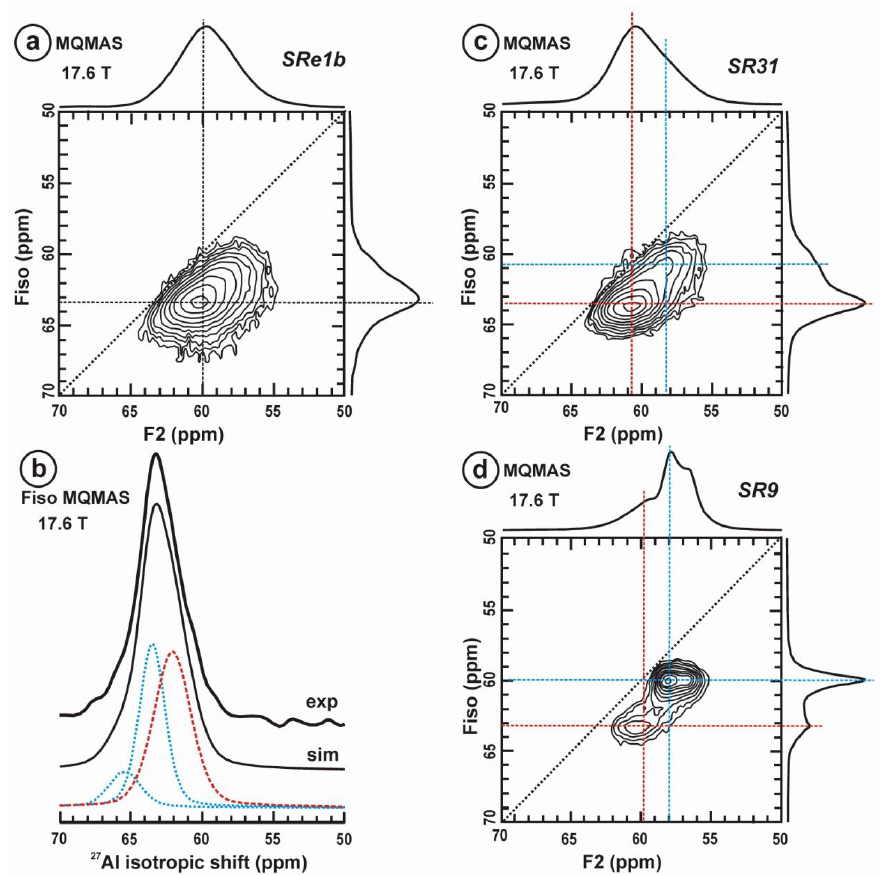
Figure 21. The 27 Al MQMAS NMR spectra at 17.6 T of the three specimens of moonstone, the MAS spectra are on top as a projection the F2 axis, and the one-dimension spectra are at the right side as a projection on the Fiso isotropic dimension. ( a ) Specimen SRe1b with broad spectra in the two